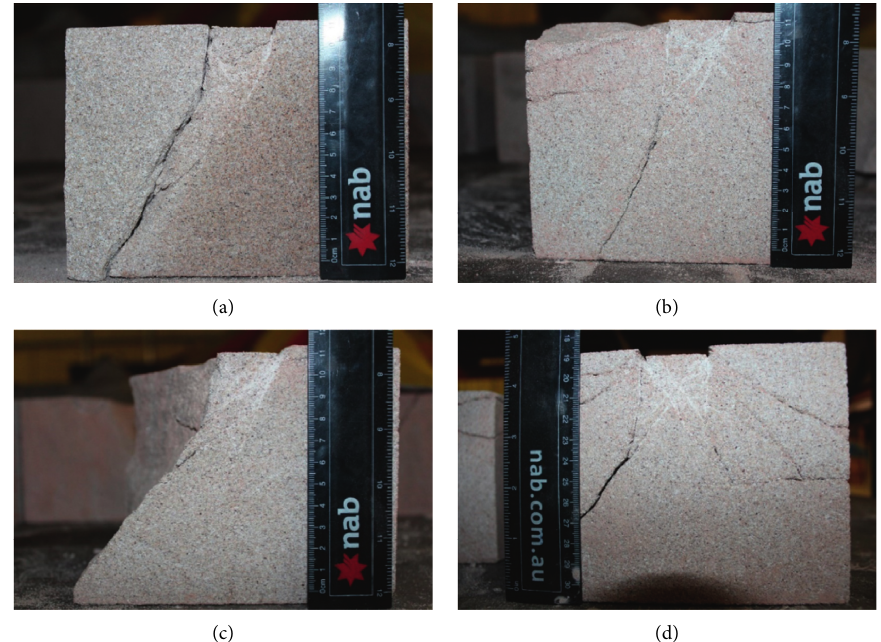
Figure 13: Crack development on the cross section under CCS disc cutter with 6mm penetration. Confining stress: (a) 0 MPa; (b) 3MPa; (c)6MPa; (d)